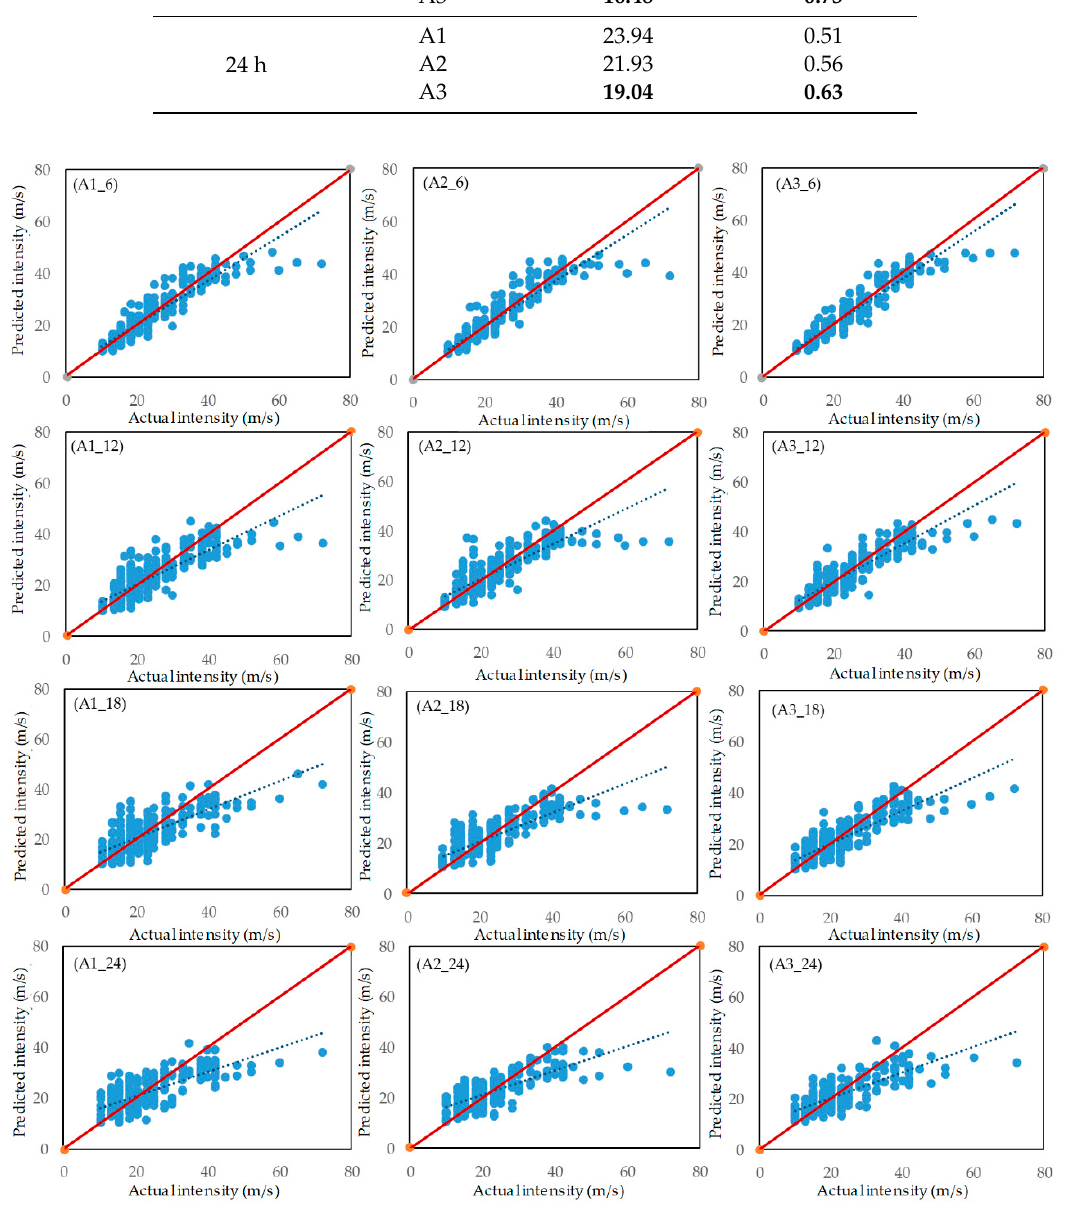
Figure 6. Scatter plots of the actual intensity and the intensities predicted by models A1, A2, and A3 at 6, 12, 18, and 24 h lead times. Actual intensity values are shown along the abscissa axes and predicted intensity values along the ordinate axes. intensity values along the ordinate